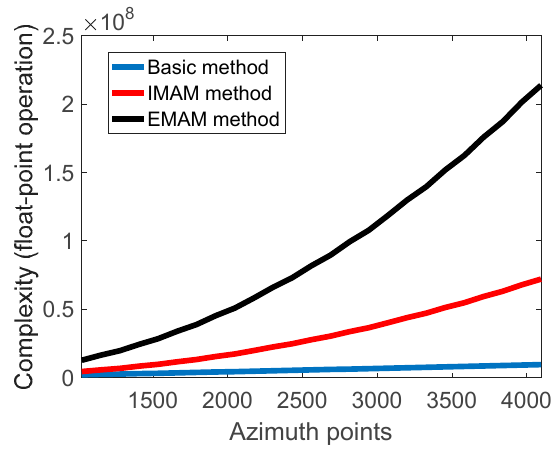
Figure 8. The computational complexity of the different methods.